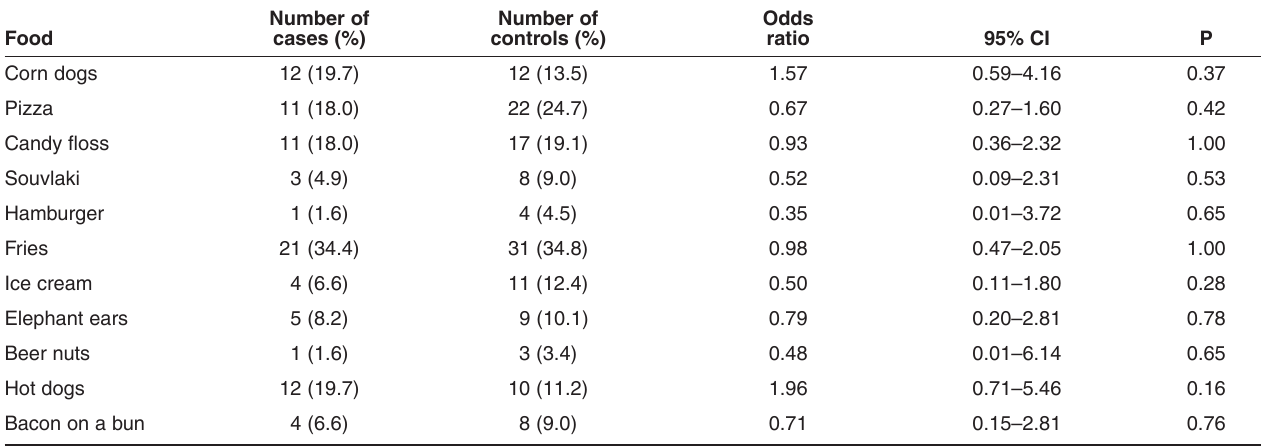
TABLE 4 Odds ratios associated with foods at the fair, Middlesex-London, Ontario,